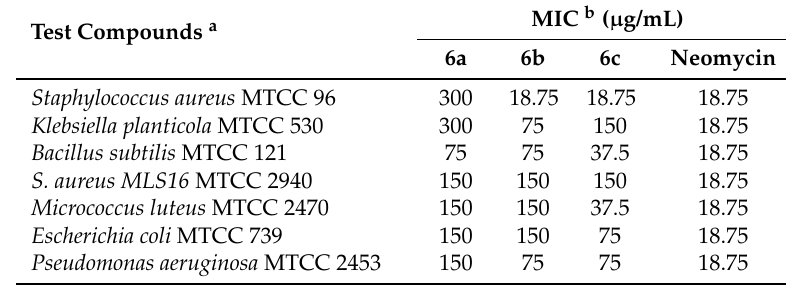
Table 2. Antibacterial activity of zinc complexes of modified polyacrylic acid 6a , 6b and 6c . Test Compounds a